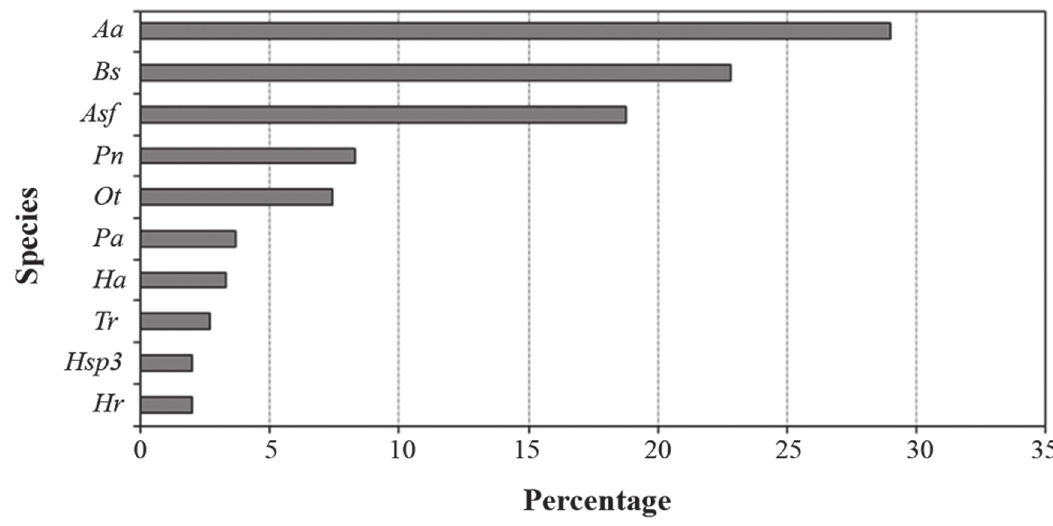
Fig. 4 . Relative abundance of species in the fish ladder. Abbreviations: Aa – Apareiodon affinis ; Bs – Bryconamericus stramineus ; Asf – Astyanax fasciatus; Pn – Parodon nasus ; Ot – others; Pa – Piabina argentea; Ha – Hypostomus ancistroides; Tr – Tilapia rendalli; Hsp3 – Hypostomus sp. 3 ; Hr – Hypostomus cf.